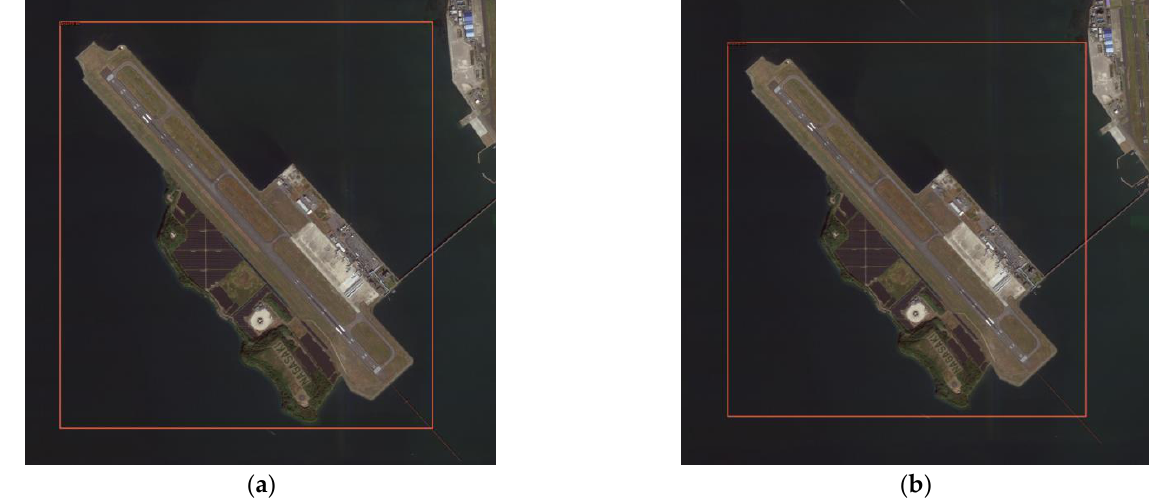
Figure 8. Airport prediction comparison: ( a ) Swin-HSTPS airport forecast results (confidence 0.99); ( b ) Swin Transformer airport forecast results (confidence 0.95).